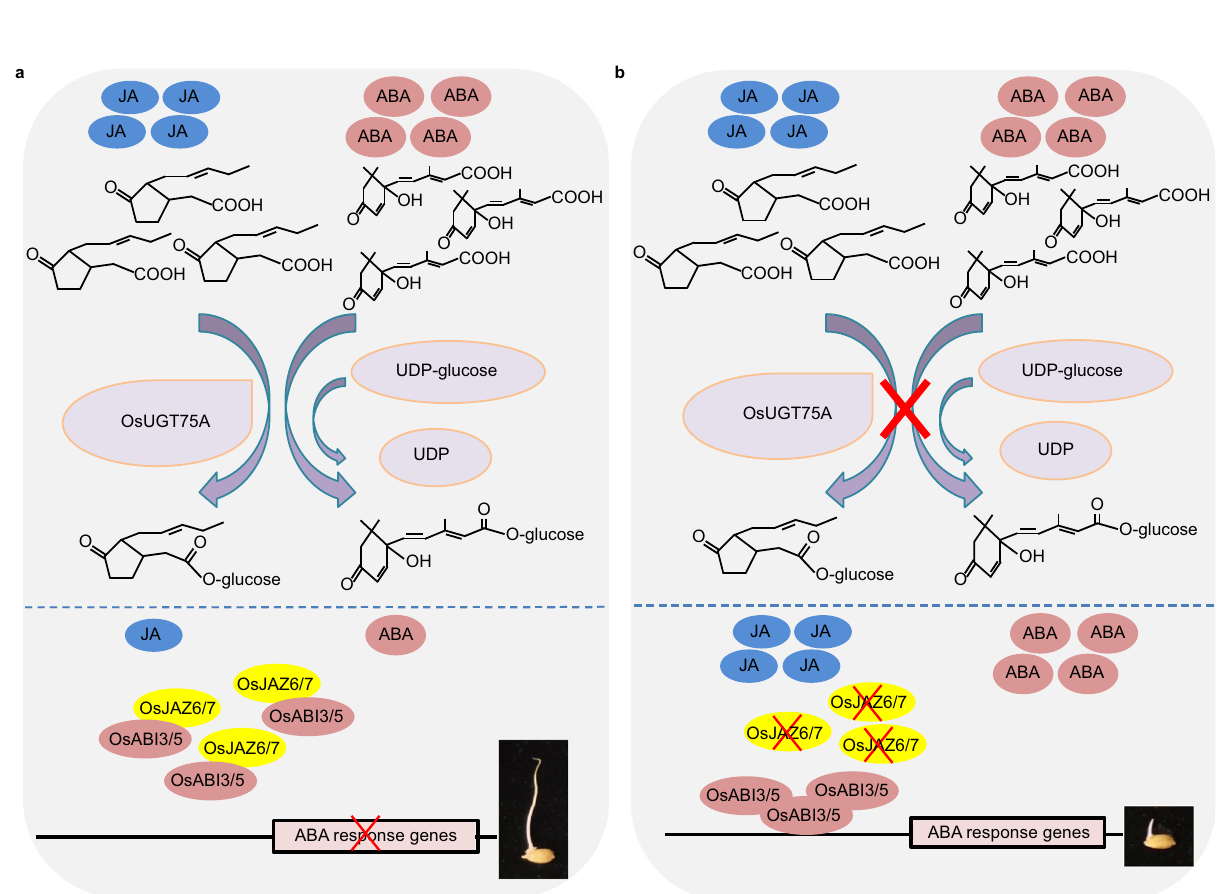
Fig. 8 | Proposed working model forthe role of OsUGT75A in the regulation of rice seed germination under submergence. a In wild-type plants, OsUGT75A catalyzestheglycosylationofabscisicacid(ABA)andjasmonicacid(JA)contributes to the decrease of free ABA and JA accumulation, which leads to the OsJAZ6/7 proteins interact directly with OsABI3/5 and repress the transcriptional activity of OsABI3/5 and subsequent regulate ABA signaling pathway. b In Osugt75a mutant